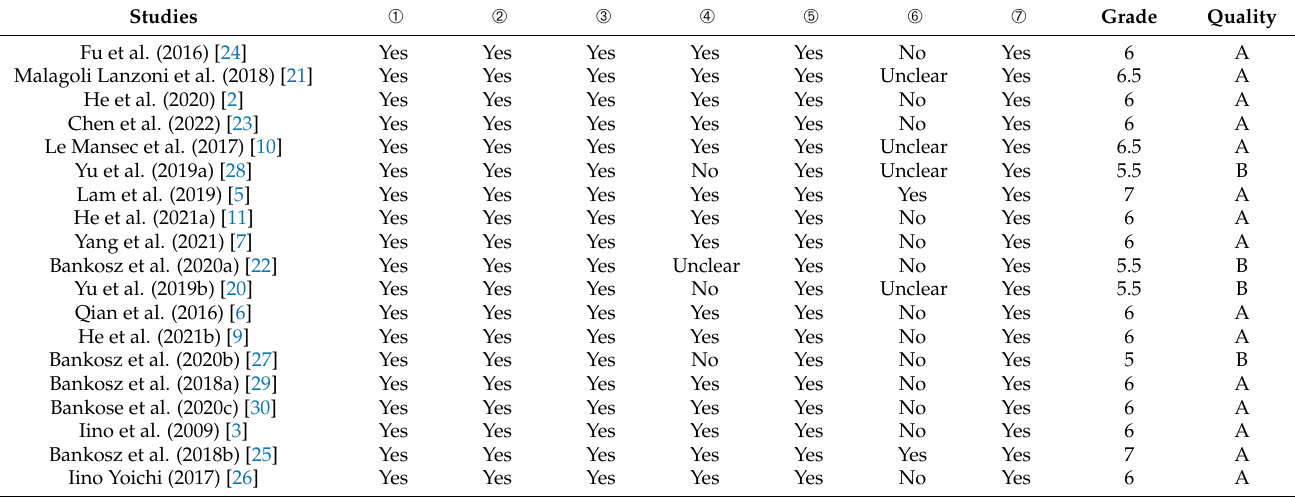
Table 3. Study risk of bias